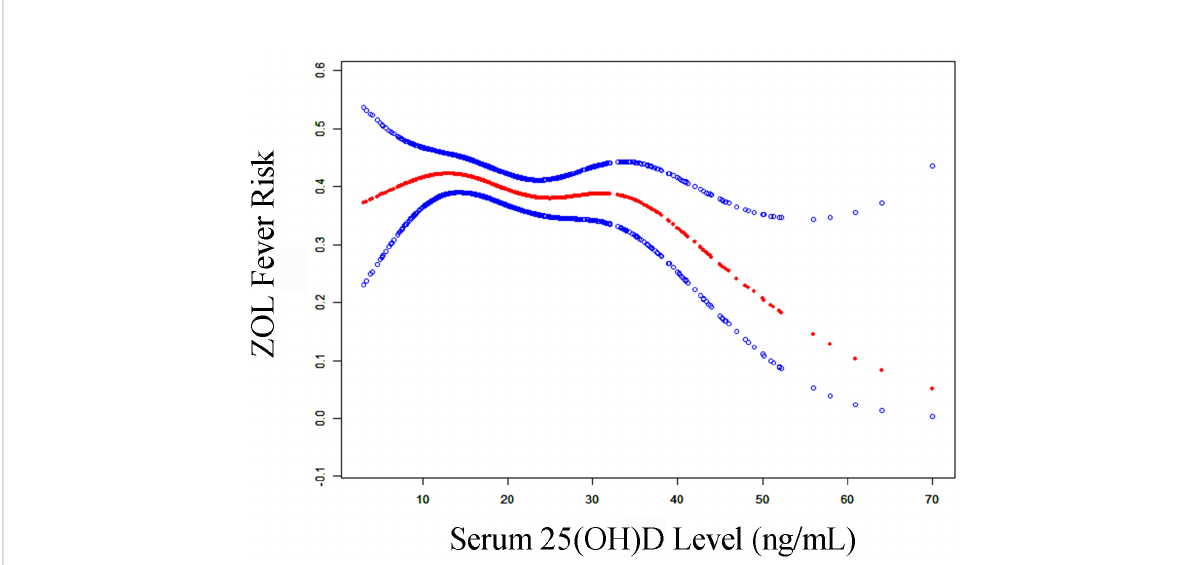
FIGURE 4 The adjusted smoothed curves of serum 25(OH)D levels and ZOL fever risk. A threshold, nonlinear correlation between serum 25(OH)D levels and ZOL fever risk, as evidenced by our generalized additive model. The red curve (middle) refers to a predicted value, and the blue curves (both sides) refer to the 95% CIs. Adjustment factors included gender, order of ZOL infusion, main diagnosis, season of blood collection, year of blood collection, calcitonin usage, and b -CTX. The turning point (K) of the curve in Model II was 35 ng/mL. CI, con fi dence interval; b -CTX, beta- C-terminal telopeptide of type I collagen; 25(OH)D, 25-hydroxy vitamin D; ZOL,